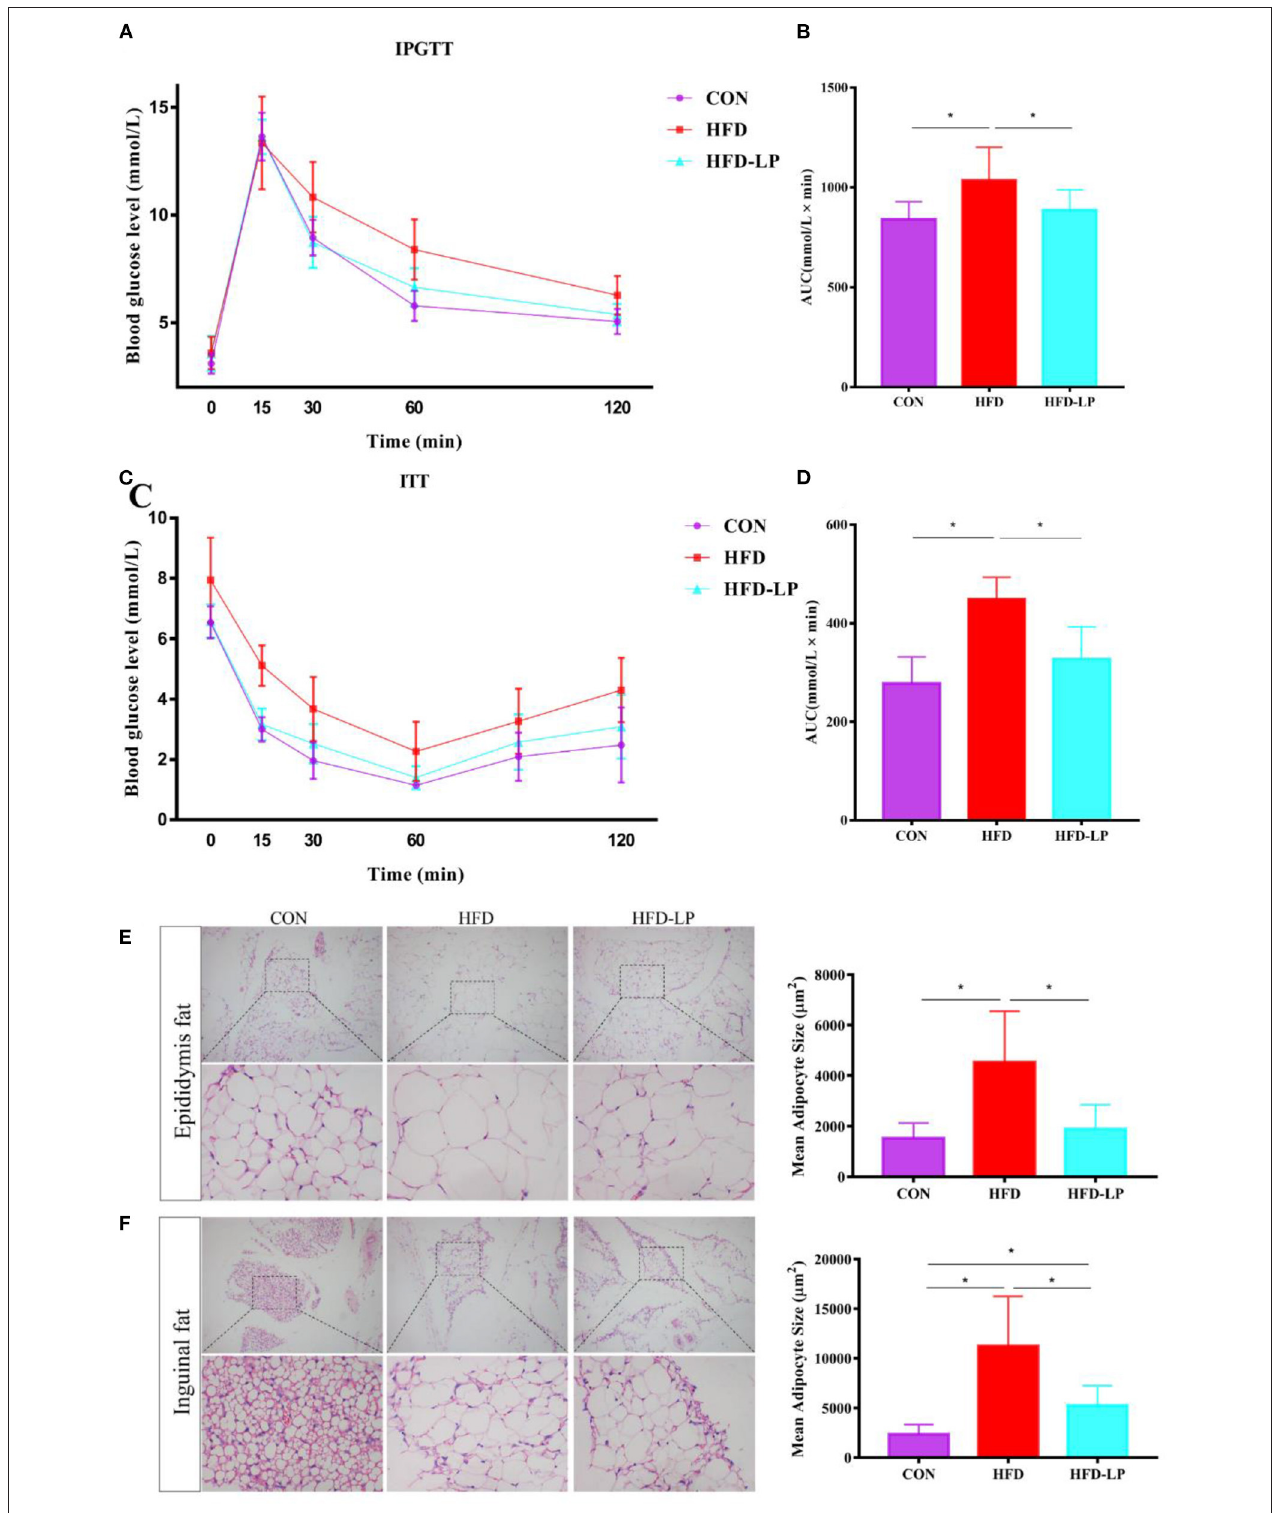
FIGURE 2 | Effect of Lactobacillus plantarum on glucose tolerance, insulin resistance and fat morphology in obese mice. (A) Plasma glucose level in mouse glucose tolerance test; (B) The area under the glucose curve (AUC) using the trapezoidal rule; (C) Plasma glucose level in mouse insulin tolerance test; (D) The area under the glucose curve (AUC) using the trapezoidal rule. (E) H&E staining on epididymal fat depots. Representative sections from inguinal fat depots of all groups (400 × ). Histological analysis of mean adipose cell size. (F) H&E staining on inguinal fat depots. Representative sections from inguinal fat depots of all groups (400 × ). Histological analysis of mean adipose cell size. Data are mean ± SD ( n = 8) and analyzed by one-way ANOVA. * p < 0.05.